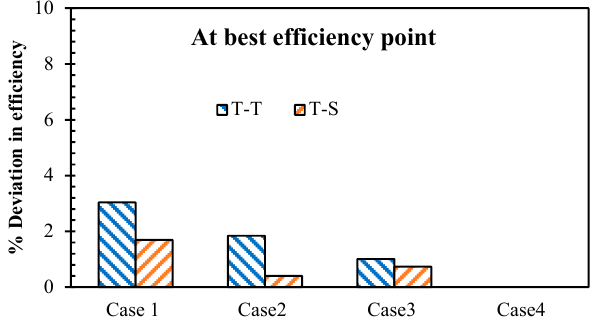
Figure 23. Time step study of the transient model and comparison of the deviation of Cases 1 to 3 from the Case 4.